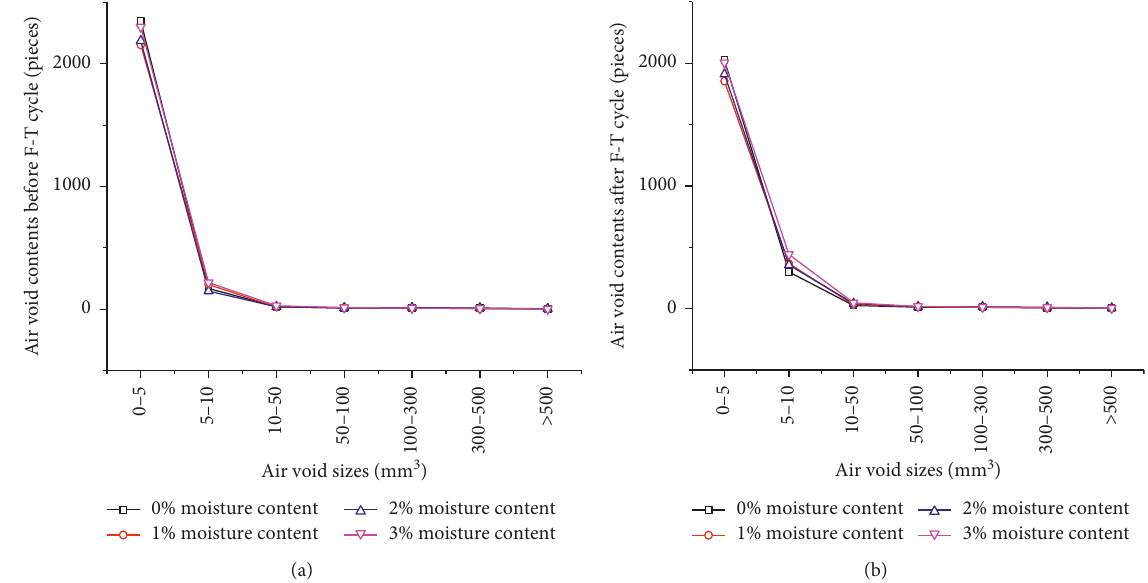
Figure 4: Air void contents and their sizes of the RH-WMA through freeze-thaw cycles.